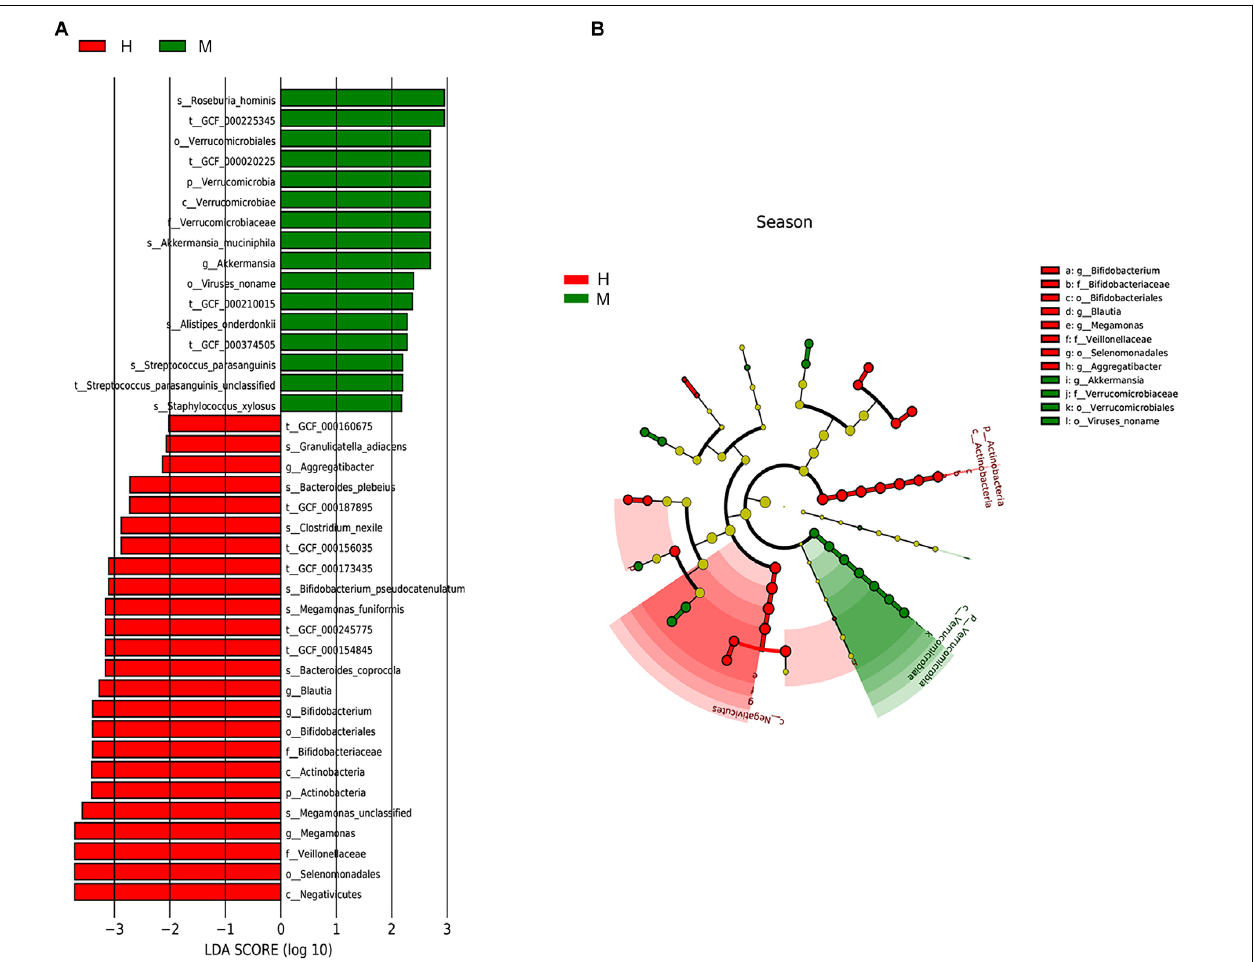
FIGURE 3 | Taxonomic differences of gut microbiota in MSA and healthy groups predicted on different levels. (A) Histogram of the LDA scores computed for taxa differentially abundant between groups. (B) Cladogram indicated the phylogenetic distribution of fecal microbiota associated with MSA and healthy subjects. Each dot represented a taxonomic entity and the taxonomic levels ranged from phylum to species from the inner to outer